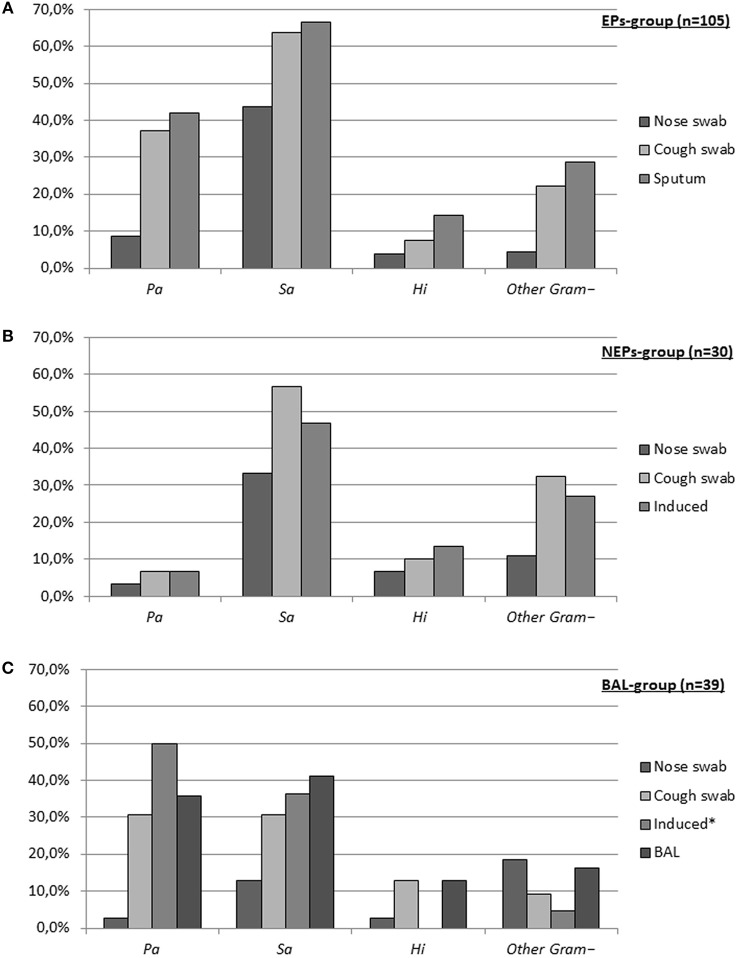
Prevalence of pathogens for each sampling method. (A) Expectorating patients (EPs), (B) Non-expectorating patients (NEPs), (C) BAL-group. (Pa, Pseudomonas aeruginosa; Sa, Staphylococcus aureus (methicillin-resistant Sa n = 1 in expectorating patients and BAL-group and n = 0 in non-expectorating patients); Hi, Haemophilus influenzae; Other Gram–, other gram negative organisms (see Table 3). *Only 22 patients in BAL-group provided induced samples).